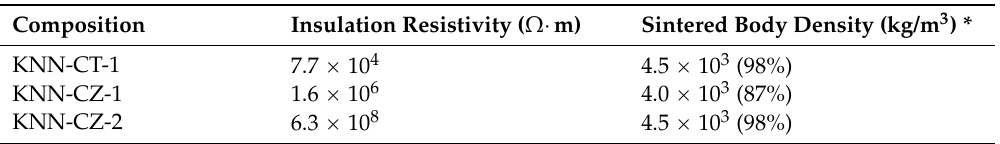
Table 1. Insulation resistivity and sintered body density of single-layer disk samples (measured temperature: 25 °C).